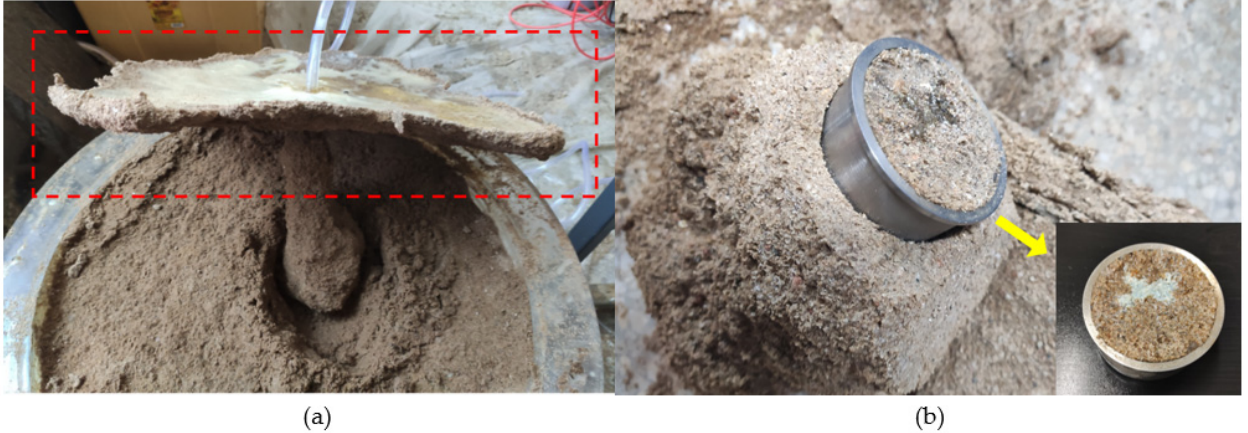
Figure 8. Obtaining a chemical grouted sands specimen: ( a ) excavation of chemical grouted sands; ( b ) sampling by cutting ring.